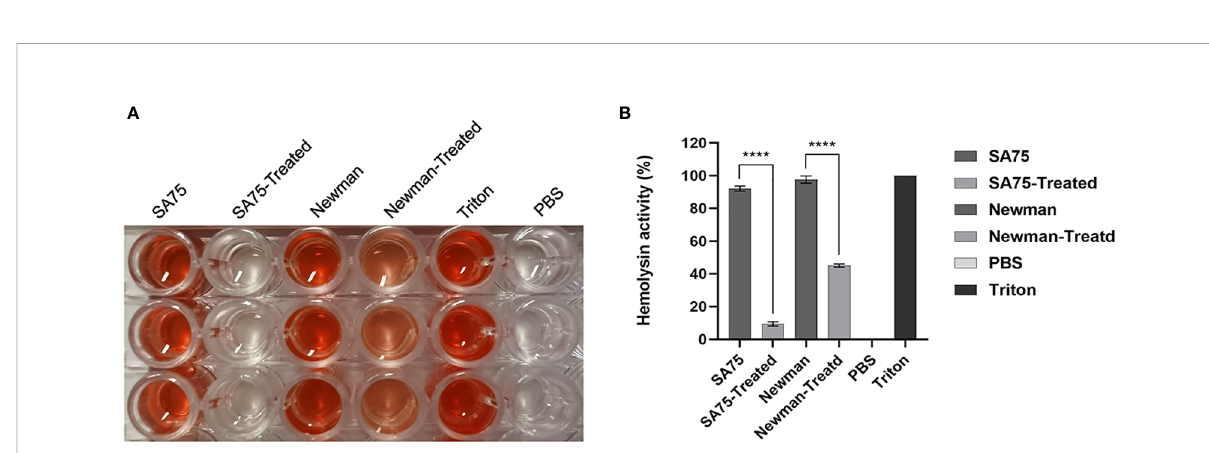
FIGURE 2 Effect of SYG-180-2-2 on the hemolytic activity of S. aureus strains. Triton X-100 and PBS were used as positive and negative control, respectively. (A) The images show the hemolysis of supernatant. (B) The percentage of hemolysis. **** P <